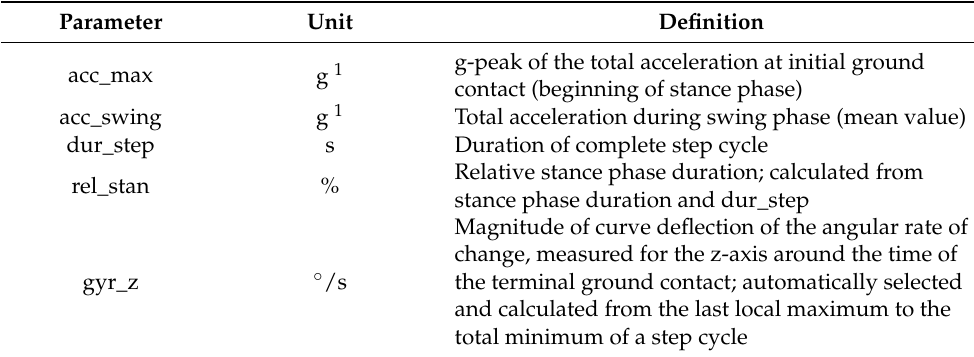
Table 1. Definition of IMU parameters used for gait